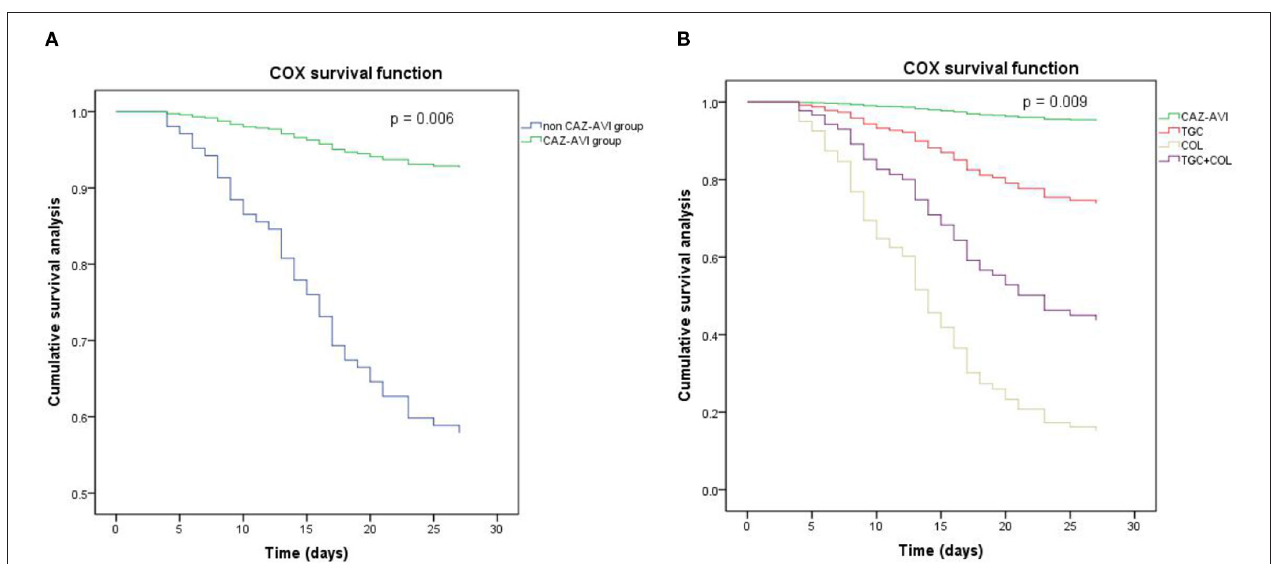
FIGURE 4 | The Cox proportional hazards regression survival analysis. (A) CAZ-AVI vs. non CAZ-AVI ( p = 0.006). (B) CAZ-AVI vs. TGC ( p = 0.093), CAZ-AVI vs. COL ( p = 0.003), CAZ-AVI vs. TGC + COL ( p = 0.012). CAZ-AVI, therapy contained ceftazidime/avibactam; TGC, therapy contained tigecycline; COL, therapy contained colistin, TGC + COL, tigecycline and colistin combined